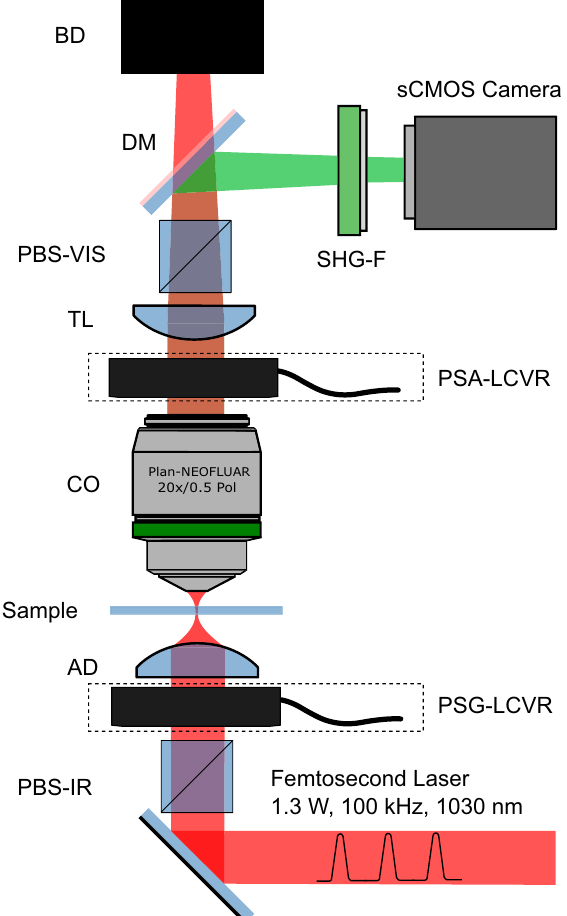
Figure 6. Widefield P-SHG microscope setup. Schematic representation of the experimental setup. The laser beam denoted in red is focused before the sample after passing polarizing beam splitter (PBS-IR), liquid crystal variable retarder of polarization state generator (PSG-LCVR) and achromatic doublet (AD). The produced SHG signal, depicted in green is collected by a collection objective (CO), passed through the liquid crystal variable retarder of polarization state analyzer (PSA-LCVR), tube lens (TL), polarization beam splitter (PBS-VIS), dichroic mirror (DM), filter (SHG-F), and projected onto the camera. The laser beam is terminated at a beam dump